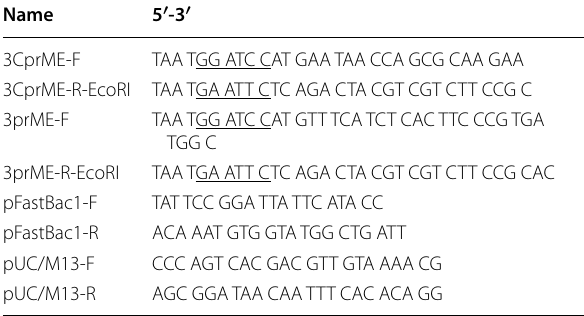
Underlines indicate restriction enzyme cleavage sites